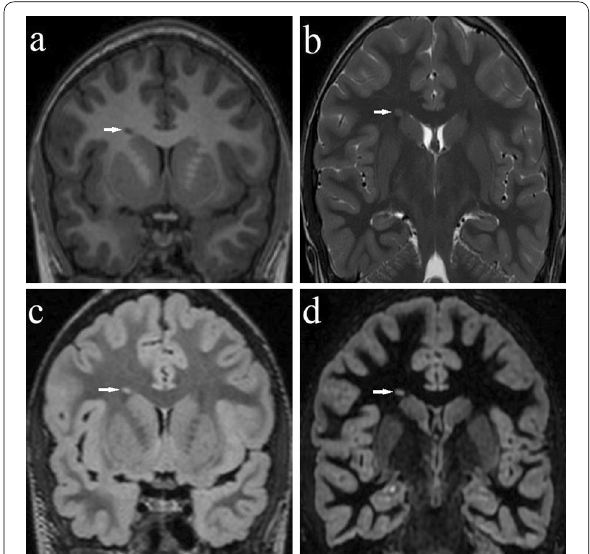
Fig. 4 Right centrum semi-ovale nodular heterotopia in a 12 years old female patient. Coronal MPGRE T1 ( a ), T2 ( b ), FLAIR ( c ) and DIR ( d ) images. A heterotopic grey matter nodule noted following the signal of the grey matter in all pulse sequences (arrows in a – d ), however, most conspicuous on 3D T1 and DIR